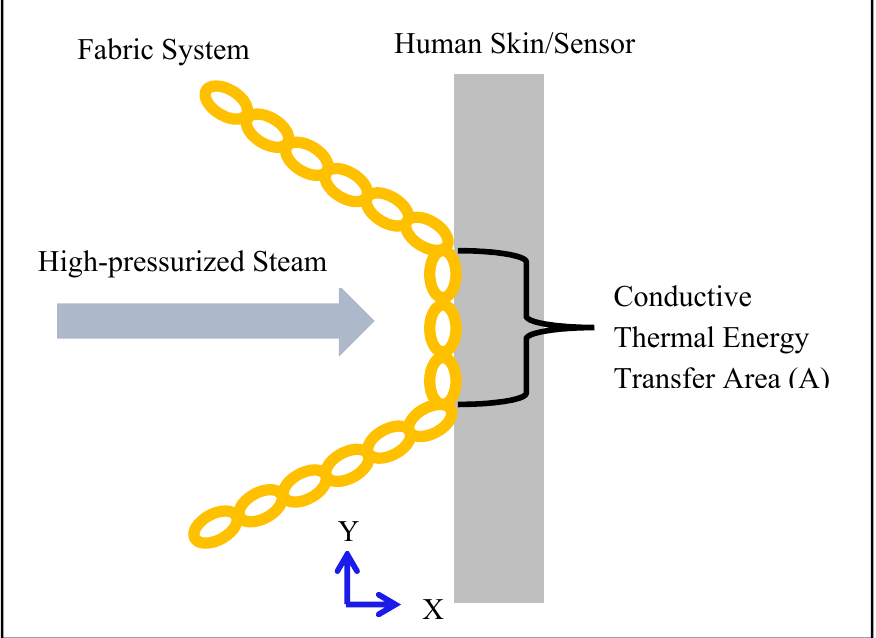
Figure 7. Conductive thermal energy transfer through a fabric system under steam exposure.